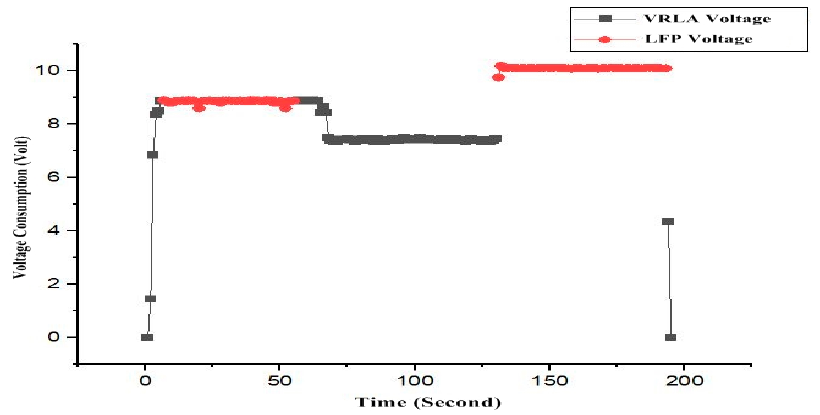
Figure 20. Dual battery voltage consumption of VRLA and LFP graph.